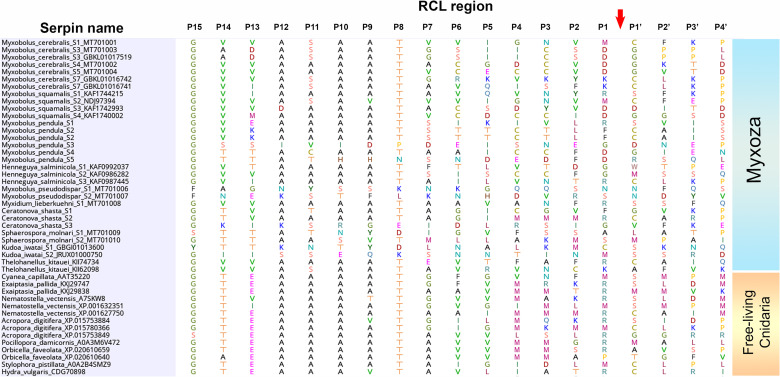
Amino acid sequences of the reactive center loop (RCL) region in the serpins of myxozoans and free-living cnidarians.The cleavage site of target protease is labeled with an arrow.